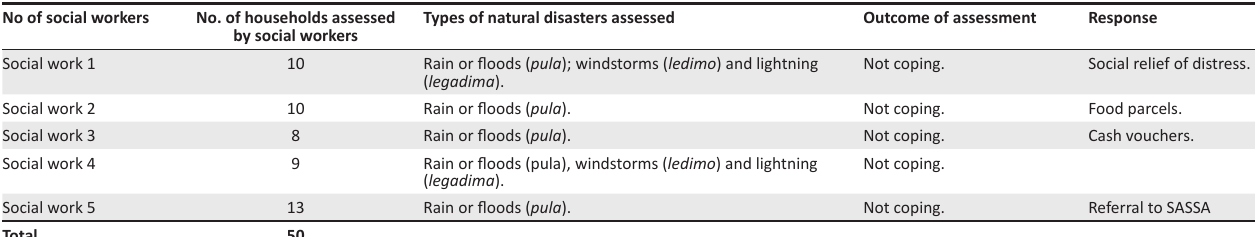
TABLE 1: Assessment of